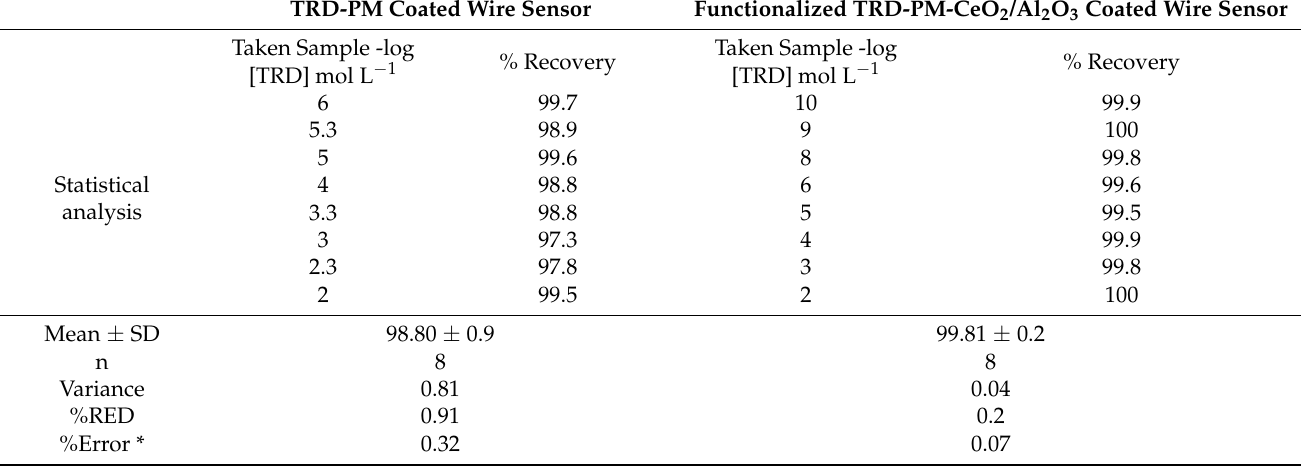
Table 3. The obtained results of the determination of TRD in its authentic samples using conventional and functionalized TRD-PM and TRD-PM-CeO 2 /Al 2 O 3 nanocomposite coated wire sensors.